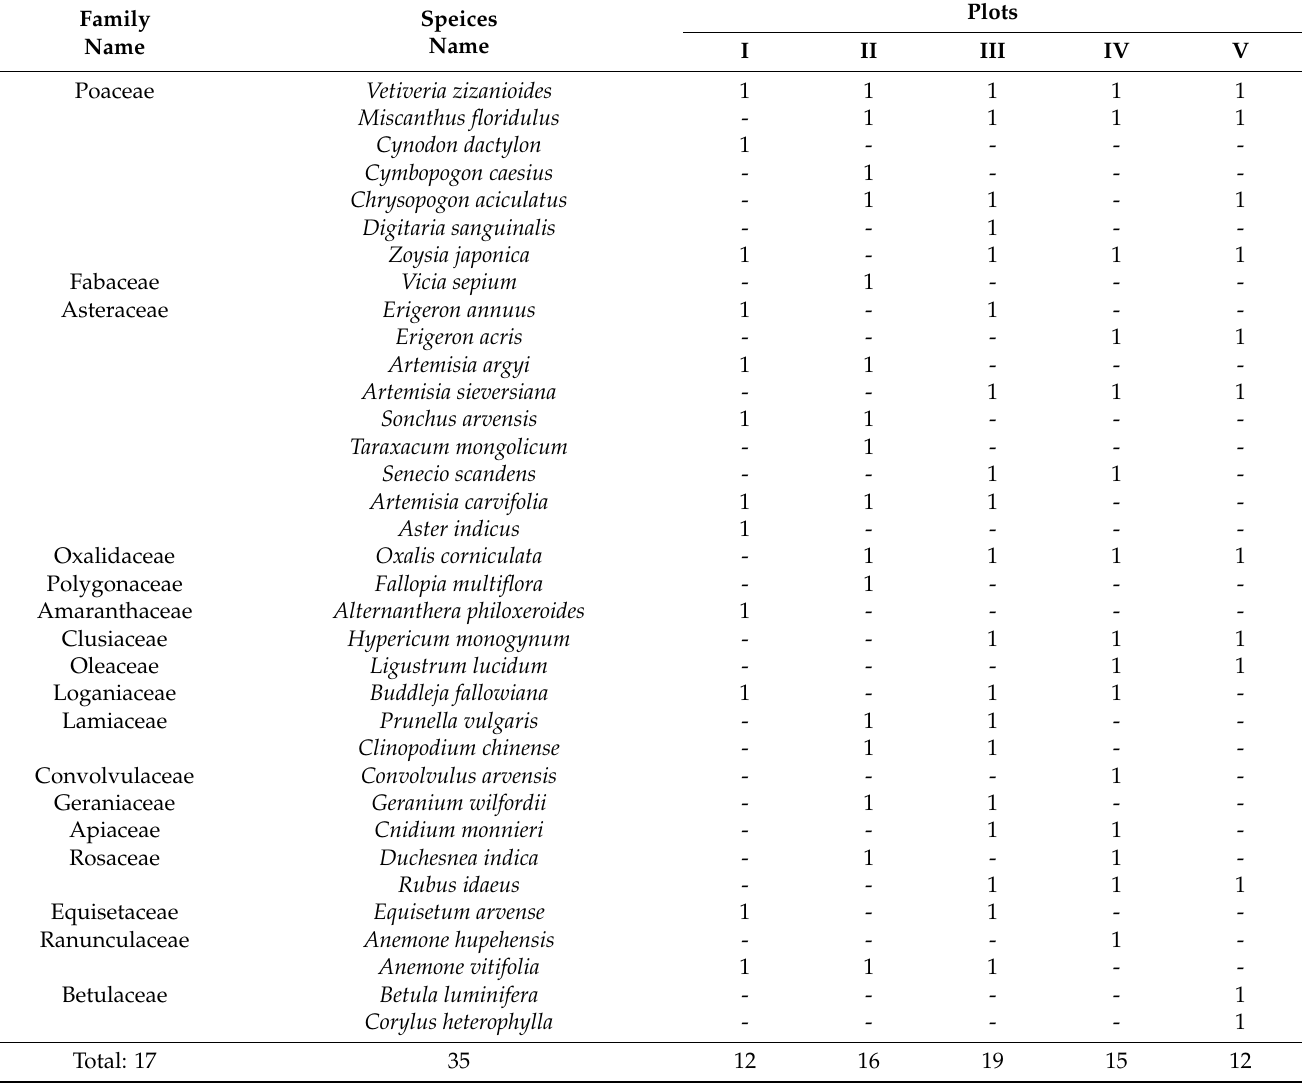
Table 2. Species composition of plots in different coal gangue mountains.